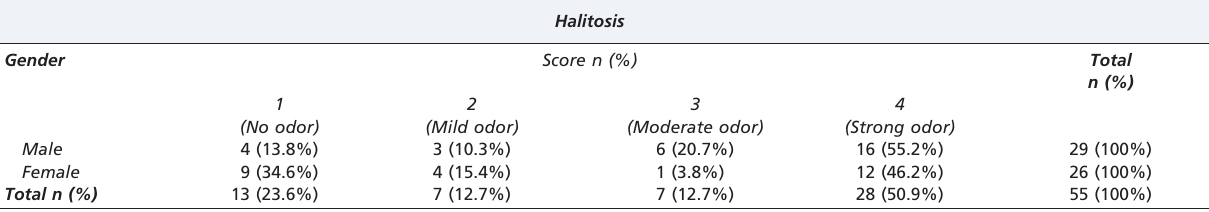
Table 2 - Analysis of the association between halitosis and gender.